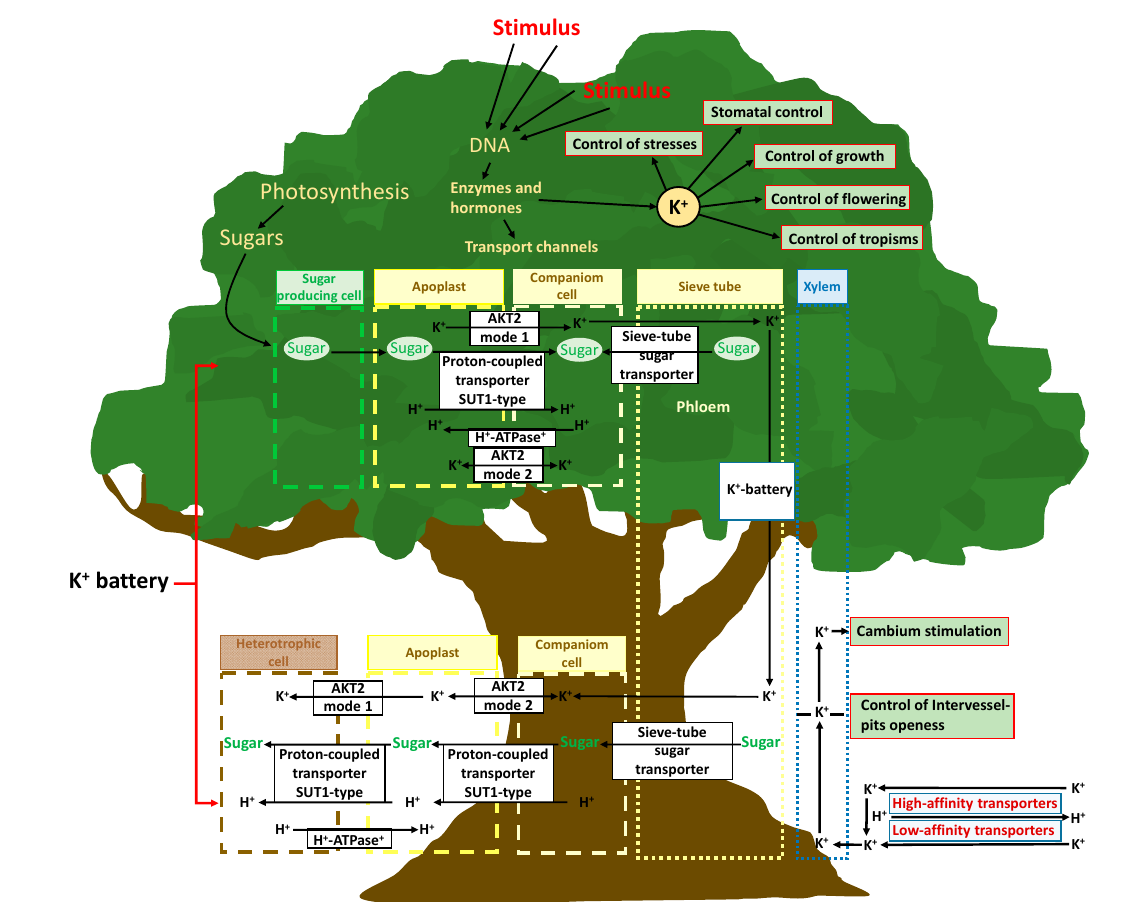
Figure 1. Schematic of the role of K + in plant antistress responses. The transcriptional and post-transcriptional control of K + passive and active membrane transporters is a central topic of current research, owing to their important role in plant development, functionality, and control of responses to environmental stresses that they activate. However, several other parallel stress mechanisms allow K + replenishment and, thus, enhance stress tolerance. Further, external or internal stimuli (e.g., drought, changes in cellular osmotic pressure or pH, changes in metabolite concentrations, or excess light or oxidation) mediate responses by activating genes encoding hormones and/or proteins that can catalyze the transcription of genes that produce high-affinity K + channels. An adequate supply of potassium allows a reduction of carbohydrates in leaf cells by counterbalance mechanisms between K + and organic osmolites in cells. Carbohydrates, mostly in terms of hexose content, are decreased in leaves due to a sufficient K + supply and transported to another plant organ, owing to better phloem activity. AKT2 transporters can operate in mode 1 as an inward-rectifying channel, or as mode 2 as a nonrectifying channel.